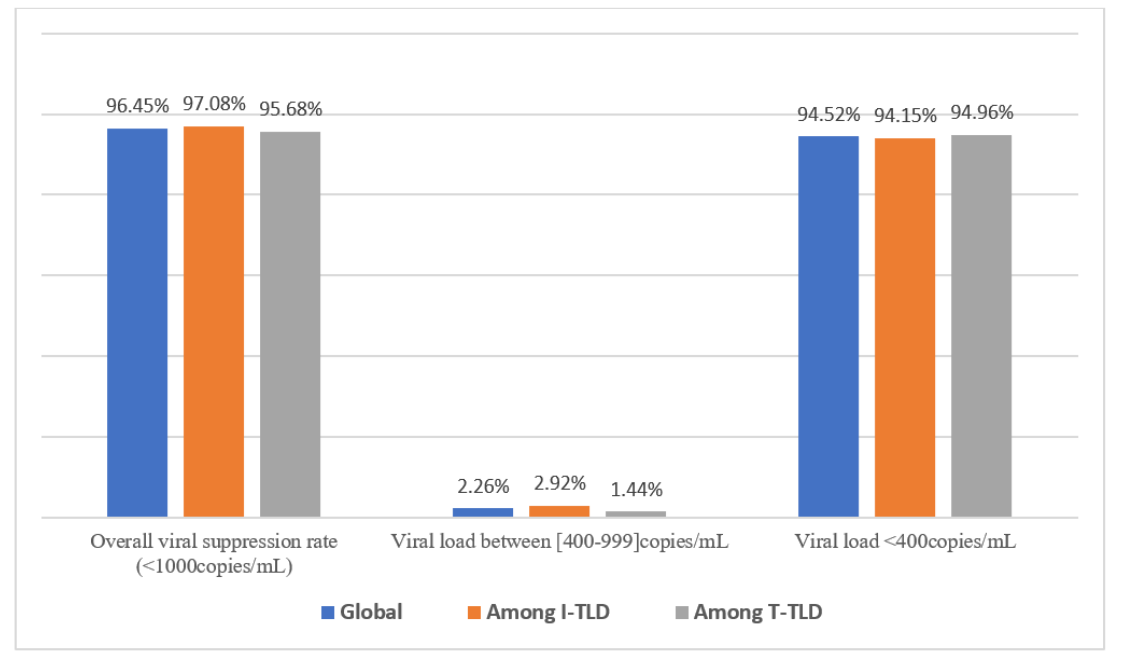
Figure 2. Virological response under TLD in first-line treatment among participants.